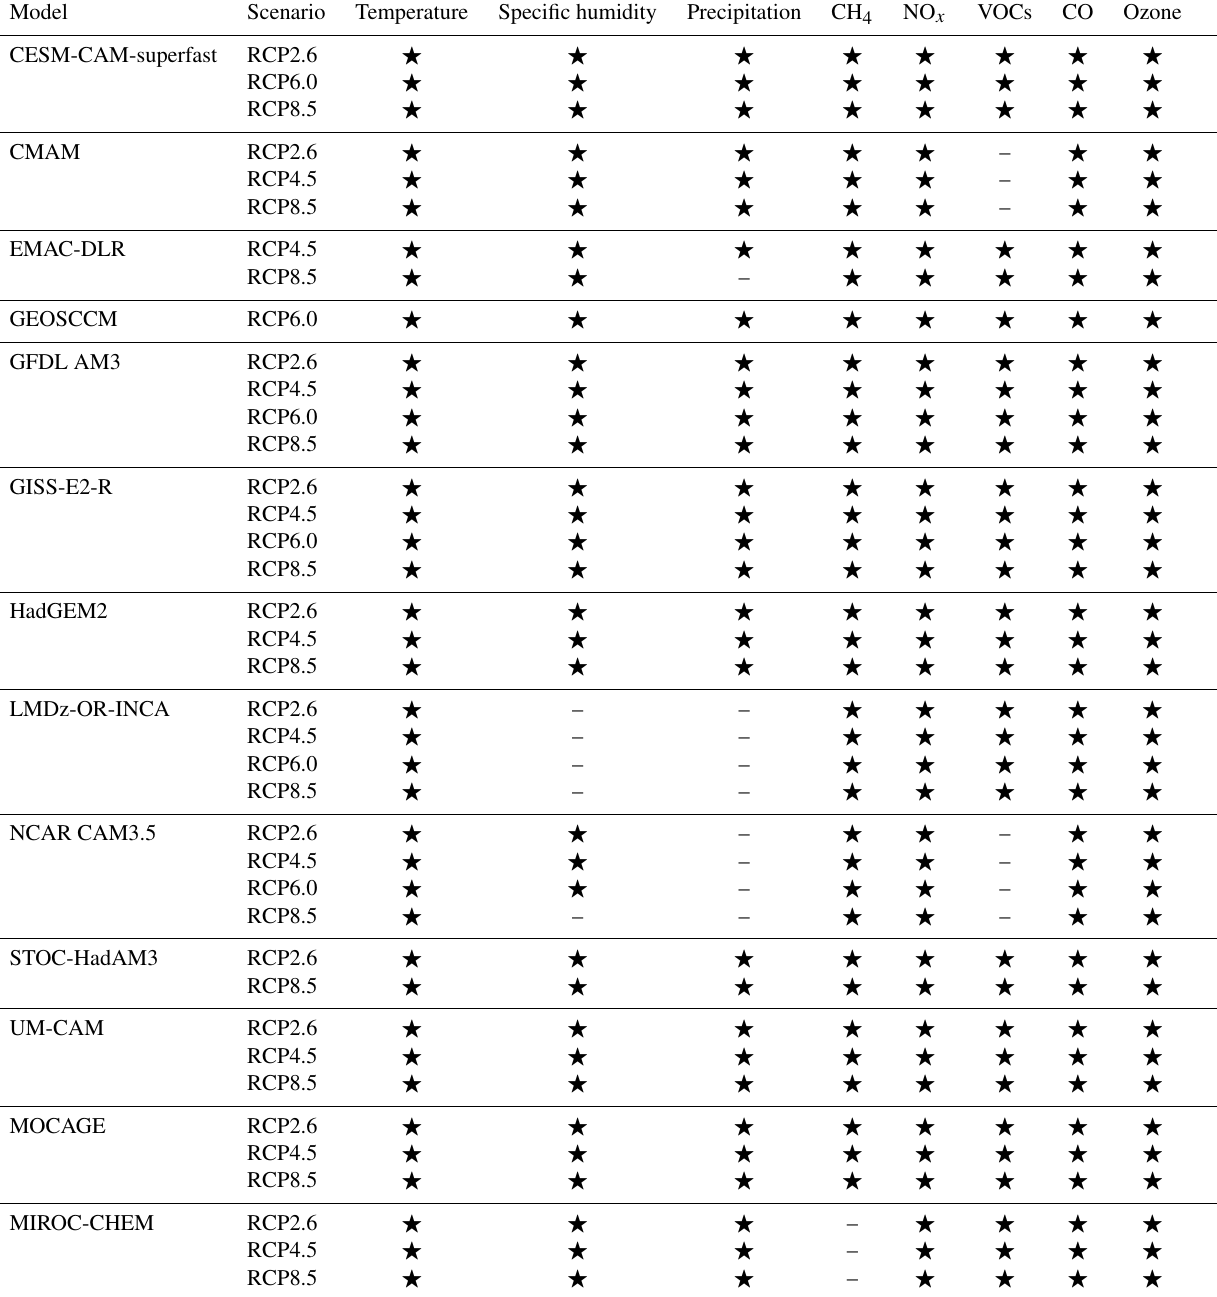
Table 2. List of the future ACCMIP simulations used in this study and the availability of data for each model, parameter and scenario. “ (cid:70) ” indicates “available” for the periods 2030 and 2100 except for GEOSCCM which is available only in 2100; “–” indicates “not available”. Model